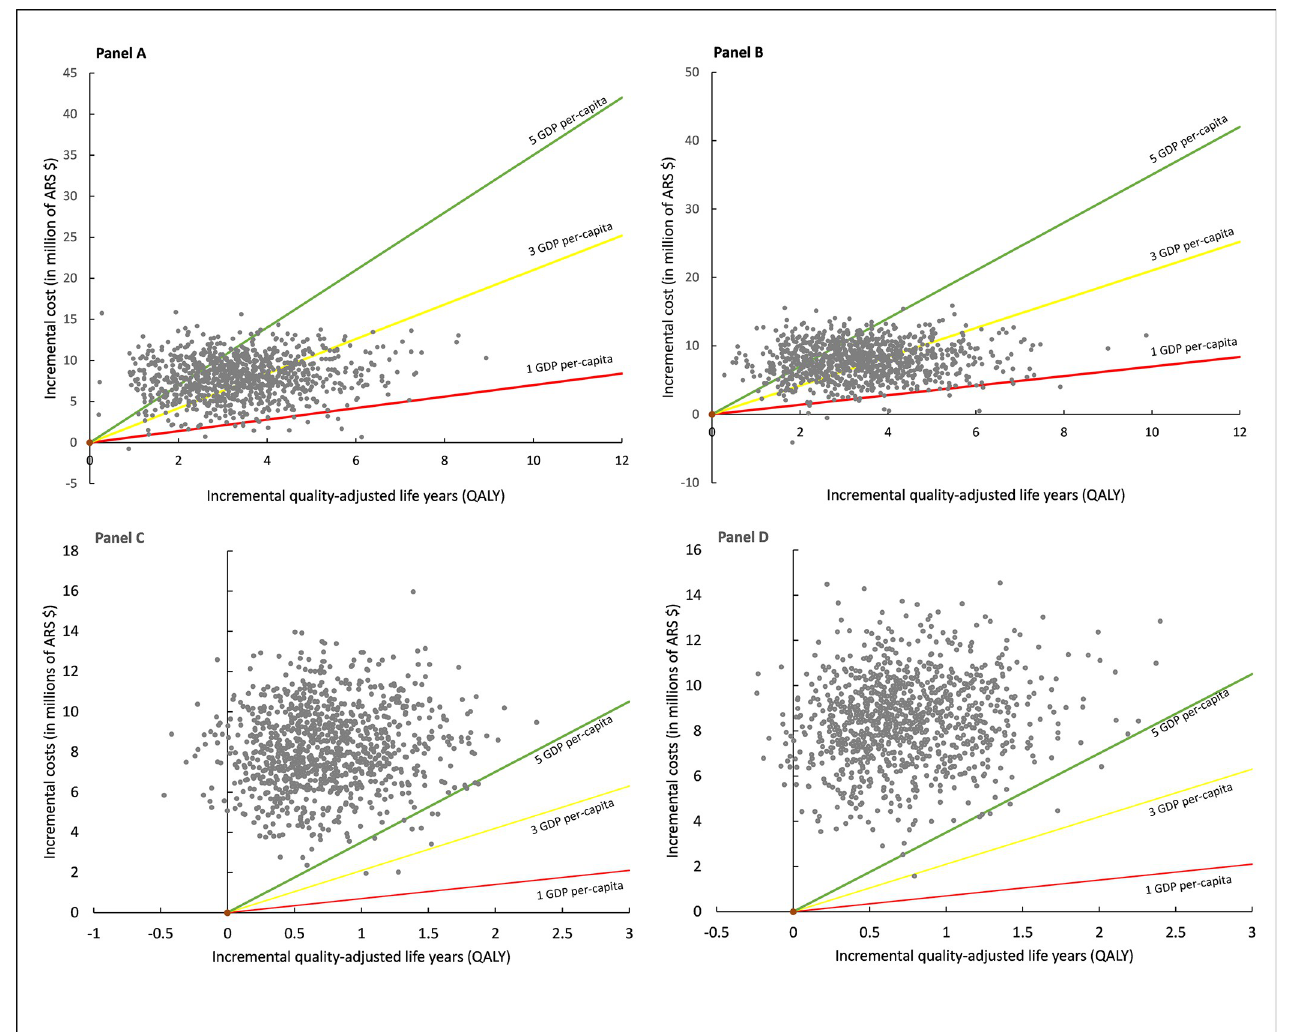
Fig 3. Incremental cost-effectiveness scatter plot for Model 1: Centrifugal-flow pump as a destination therapy in patients with contraindication for heart transplantation versus standard medical management. Panel A displays the results for the Social Security perspective and Panel B displays results for the Private Sector perspective. The incremental cost-effectiveness scatter plots for Model 2 (centrifugal-flow pump as bridge-to-transplant versus a heart transplant as treatment) are reported in Panel C (Social Security perspective) and Panel B (Private Sector perspective). The incremental cost-effectiveness scatter plots for the centrifugal-flow pump as DT or BTT are reported in Fig 3. For Model 1 (DT), the results are reported in Panel A (Social Secu- rity perspective) and Panel B (Private Sector perspective). For both perspectives, the centrifu- gal-flow pump as DT was more expensive and yielded more QALYs in comparison to the standard medical management, and all the points thus fell into the Northeast quadrant of the cost-effectiveness plane. Most of the points are above the willingness to pay threshold of 1 GDP per-capita in both perspectives, but most of the points are between the willingness to pay thresholds of 3 and 5 GDP per-capita. For Model 2 (BTT), the incremental cost-effectiveness scatter plots are reported in Panel C (Social Security perspective) and Panel D (Private Sector perspective). In some points, for both perspectives there were cases in which heart transplanta- tion as a treatment had higher QALYs in comparison to the centrifugal-flow pump as BTT.